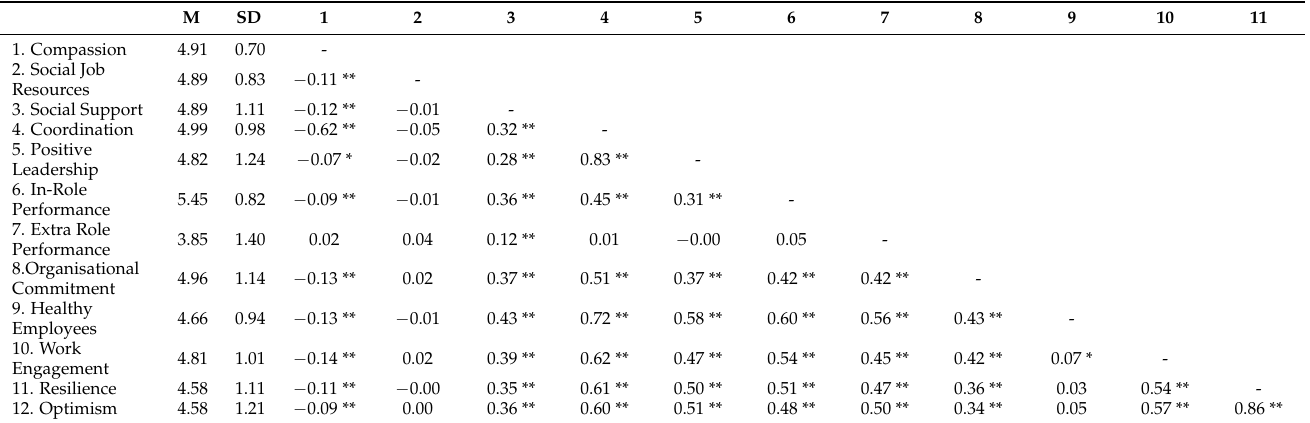
Table 2. Descriptive statistics and correlations among all study